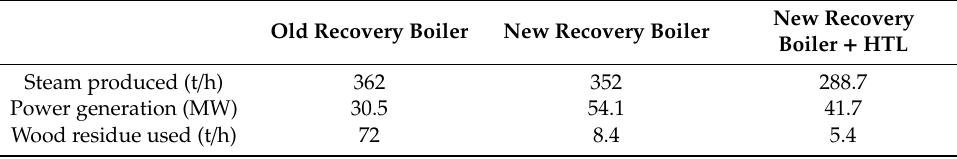
Table 8. Performance